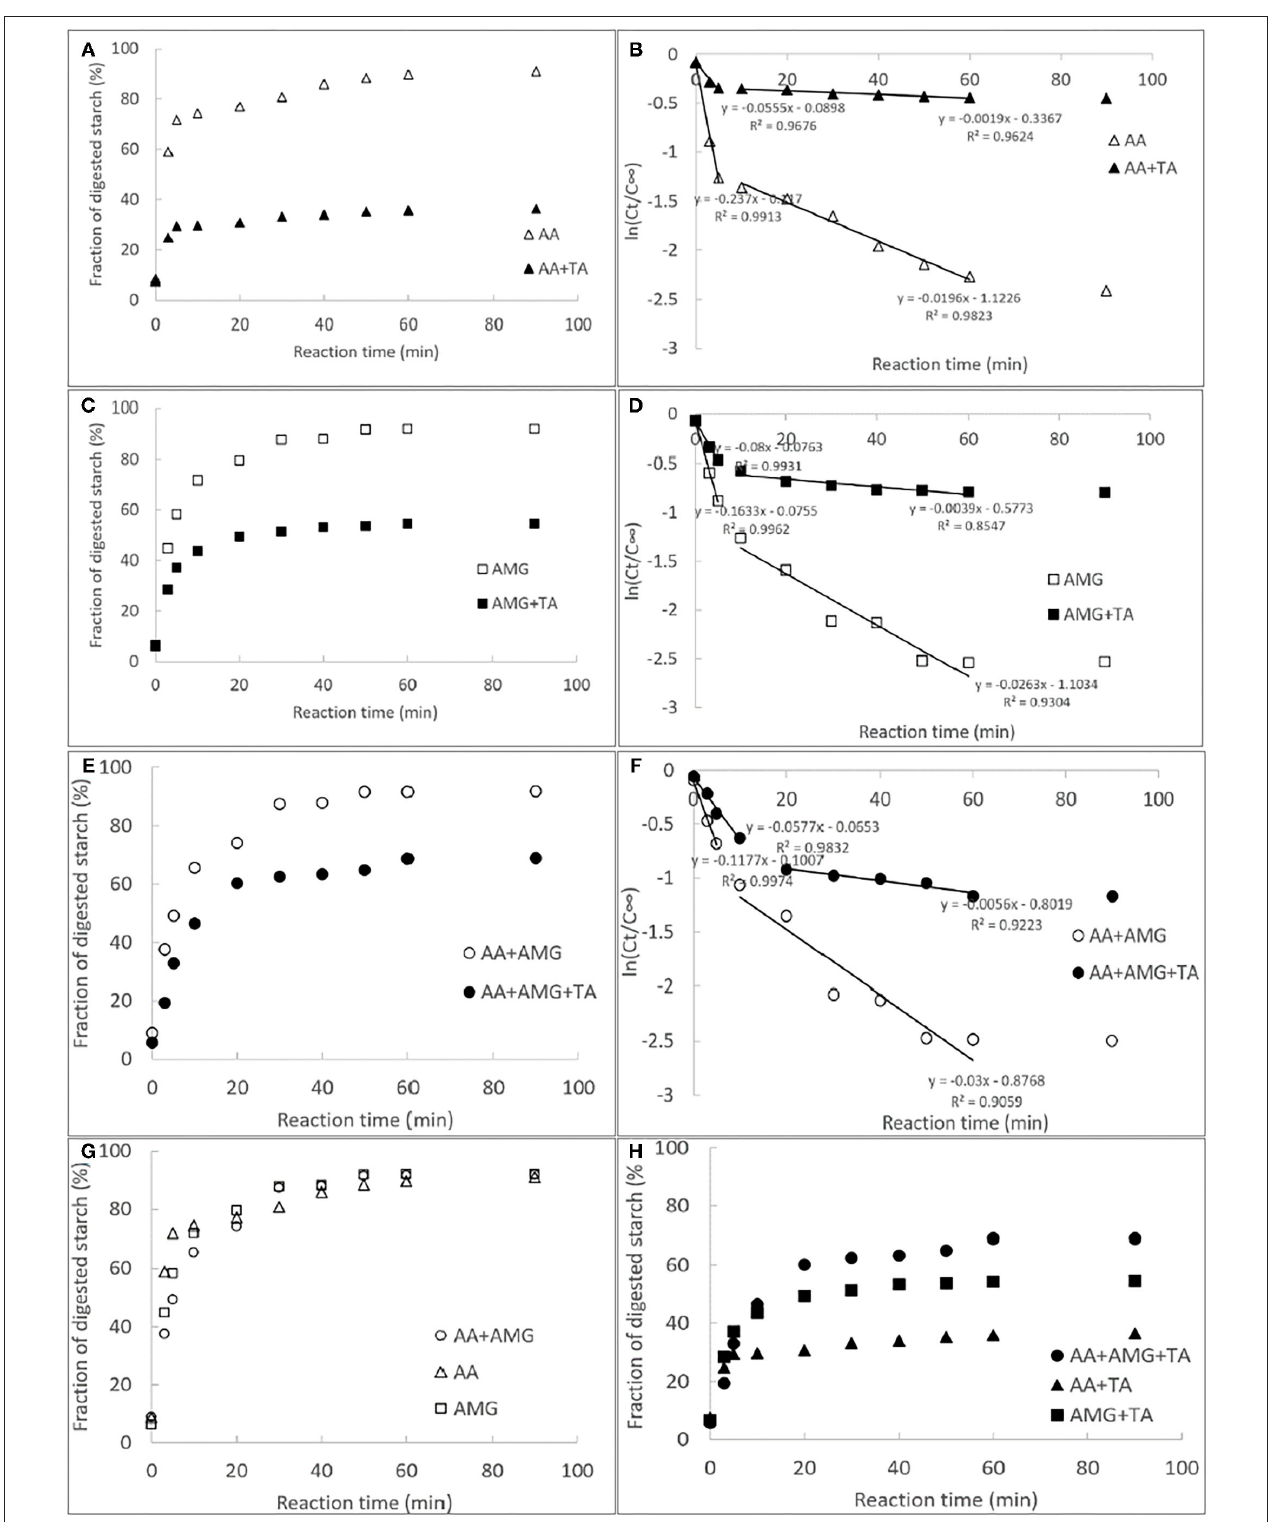
FIGURE 1 | The courses of starch digestion by individual α -amylase (AA) (A) , amyloglucosidase (AMG) (C) and AA/AMG bi-enzyme system (E) in the absence and presence of tannin acid (TA) (30 mg/ml), and the respective fitted first-order logarithm of slope (LOS) plots (B,D,F) ; in the LOS plots, the slopes of the fitted equations of at each digestion phases were calculated and defined as the digestion rate constants ( k ). The former and latter half in individual digestion profiles were the digestion phases of rapidly digestible starch (RDS) and slowly digestible starch (SDS), respectively. To describe the starch digestion processes in different enzymic systems more clearly, all the courses in the absence (G) and presence (H) of the polyphenol were specifically summarized.